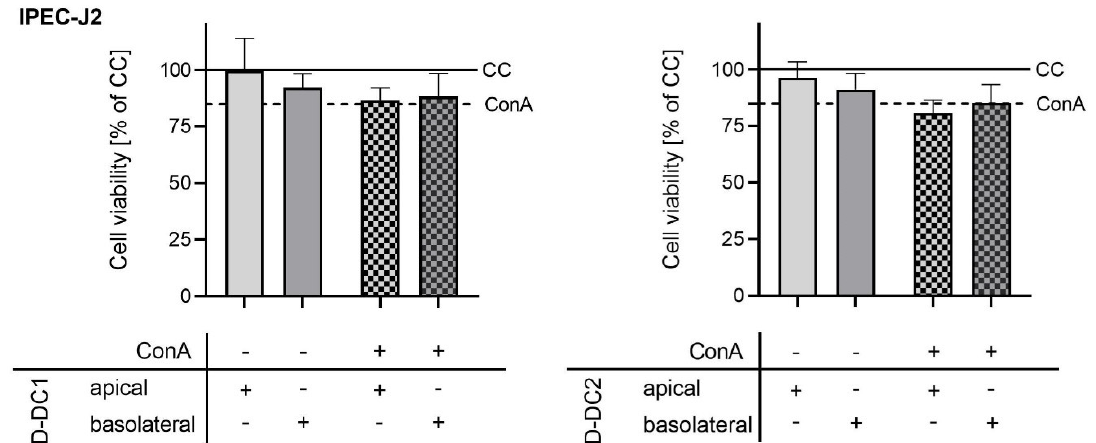
Figure 3. Effects of D-DC1 ( left ) and D-DC2 ( right ) extracts (150 µg/mL) on the viability of IPEC-J2 in the co-culture model. The viability of IPEC-J2 was determined after barrier integrity tests, 72 h after the application of stimuli and treatments, by Neutral Red (NR) test. Bars and error bars represent the means and standard deviations of 4 independent trials (n = 4). Effects of extracts D-DC1 (on the left) and D-DC2 (on the right) without ConA-stimulation were compared statistically with the unstimulated CC (solid line, 100%). Effects of the extracts in the presence of ConA-stimulation were compared statistically with the ConA-stimulated control (dashed line, ConA).